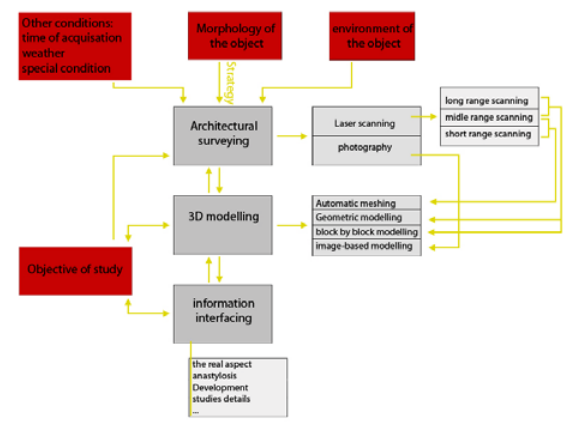
Figure 2. The 3D reconstruction strategy